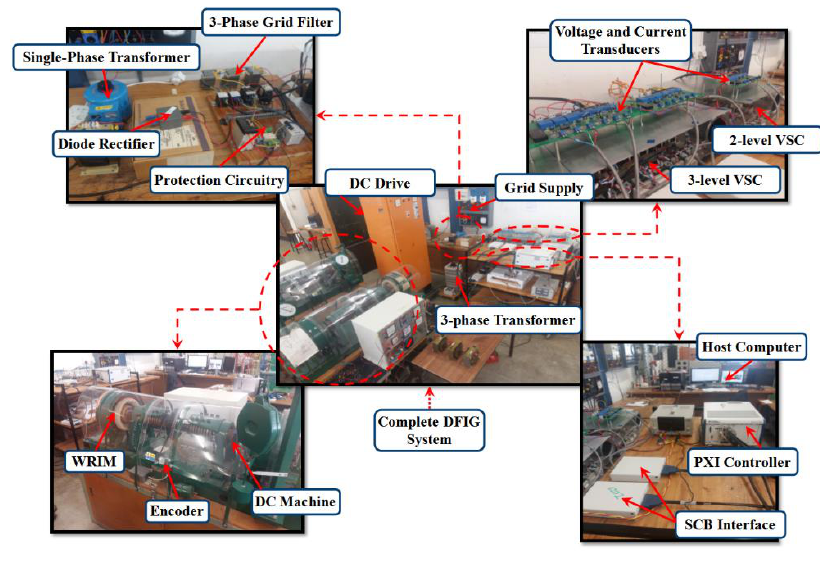
Figure 7. DFIG laboratory setup.